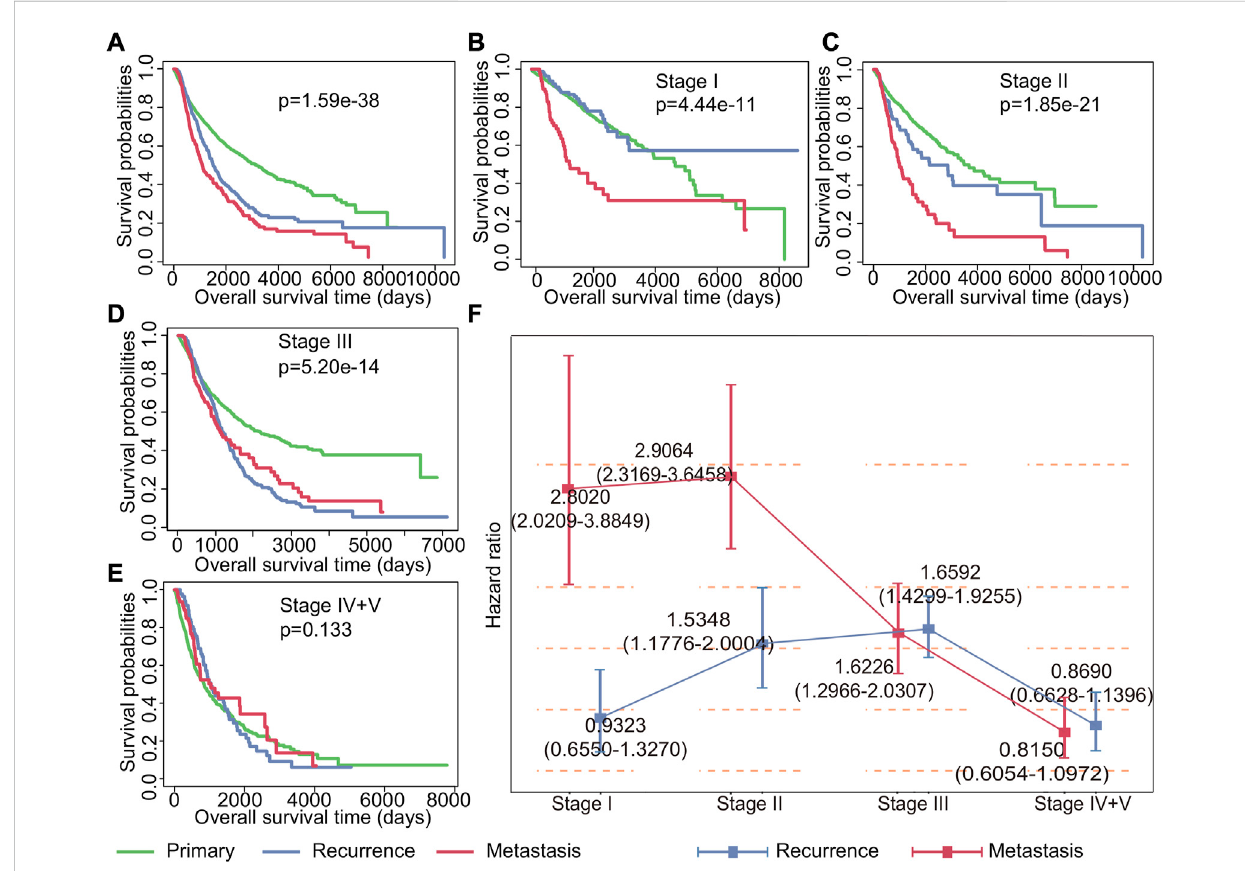
Impact of recurrence and metastasis on patients ’ survival in various stages of cancer. (A) Kaplan – Meier survival curves of all patients with primary, recurrent, and metastatictumors. (B – E) Kaplan – Meier survivalcurvesofpatients with primary tumors,recurrent tumors, and metastatictumors